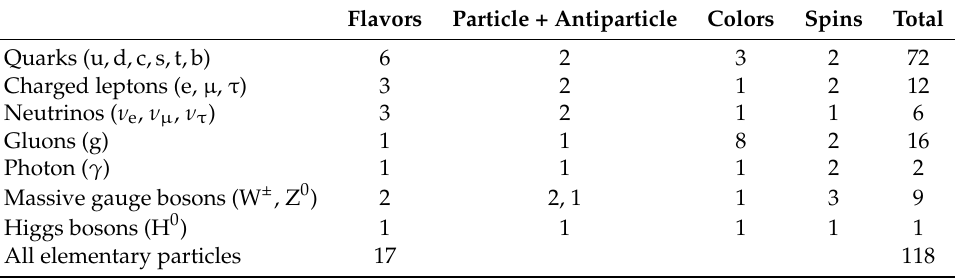
Table 1. The Standard Model of elementary particles and their degeneracies. Flavors Particle + Antiparticle Colors Spins Total Quarks (u,d,c,s,t,b) 6 2 3 2 72 Charged leptons (e, µ , τ ) 3 2 1 2 12 Neutrinos ( ν e , ν µ , ν τ ) 3 2 1 1 6 Gluons (g) 1 8 2 16 Photon ( γ ) 1 1 1 2 2 Massive gauge bosons (W ± , Z 0 ) 2 2, 1 1 3 9 Higgs bosons (H 0 ) 1 1 1 1 1 All elementary particles 17